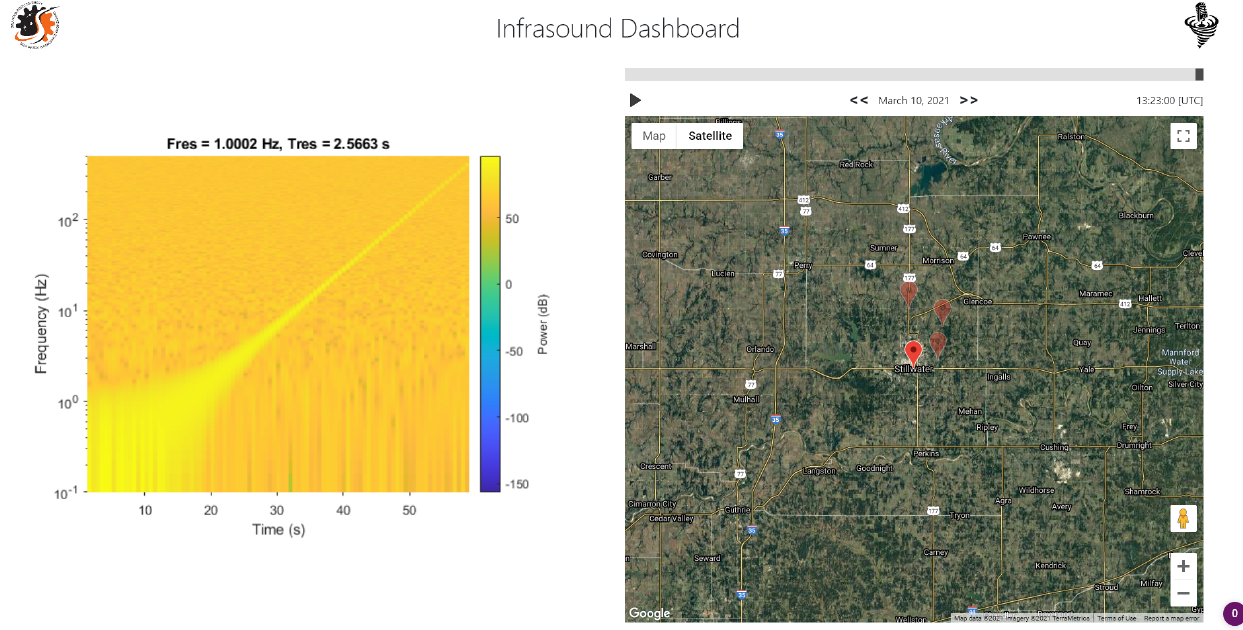
Figure 5. Example visualization of the GLINDA-monitoring web interface (see map graphic for copyright).